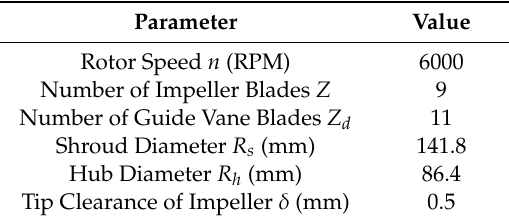
Table 1. Parameters of axial-flow fan model.